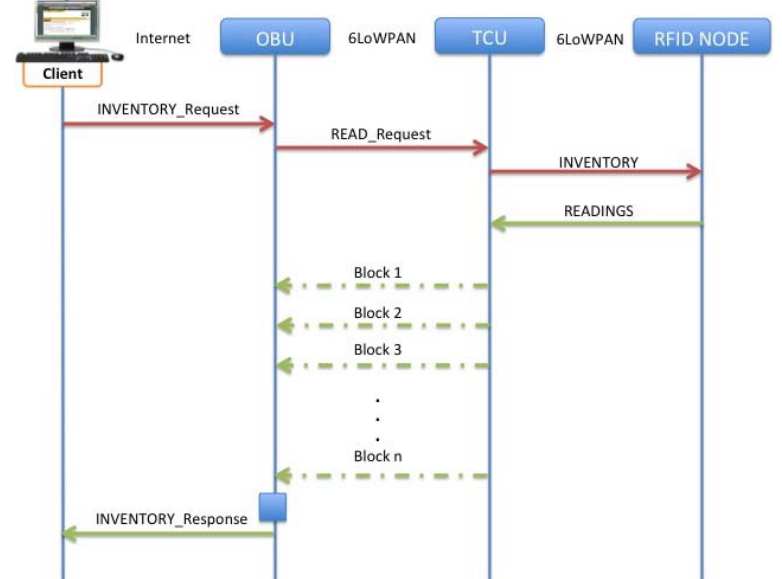
Figure 18. Request and Response interactions based in Block-wise transfers.